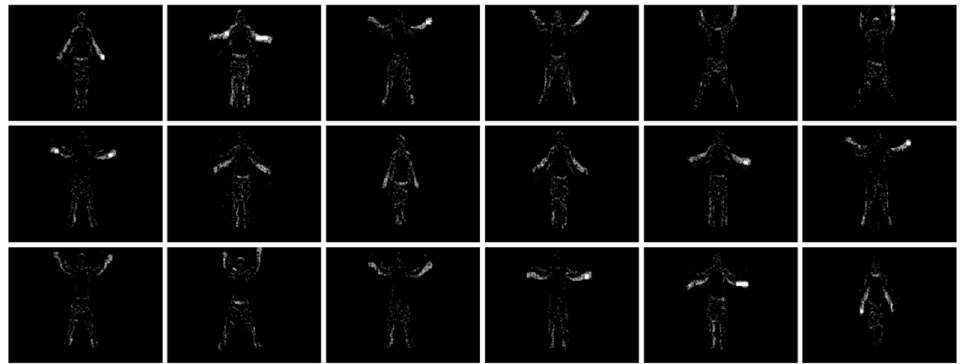
Figure 5. Action Frames after Applying the Growth Operation.